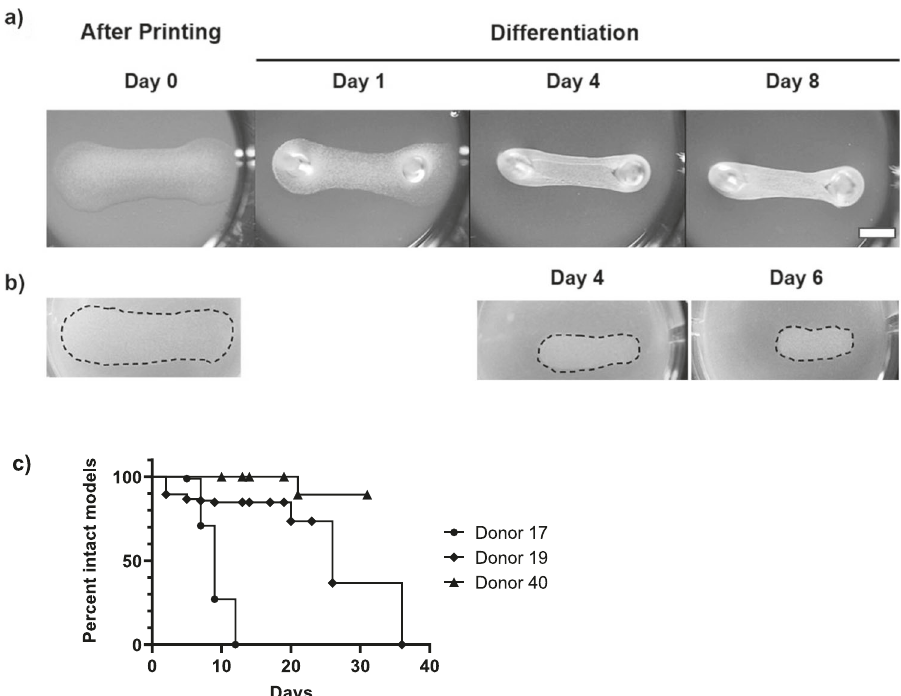
Fig. 2 Morphological tissue development in 3D bioprinted Matrigel/cell models. a Macroscopic images of a typical Matrigel/cell model after printing (day 0) and following fi xation with two micro-posts in differentiation medium at day 1, 4 and 8. Scale bar, 2 mm. b Macroscopic images of a typical printed model overlaid with Matrigel after printing and during differentiation without micro-posts at day 4 and 6. c Time course of the survival of models from different donors until they tore between the micro-posts. Shown are the results ≥ 2 independent